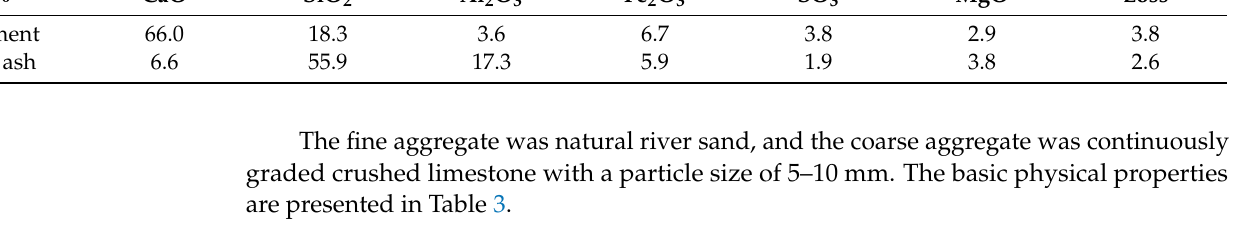
Table 3. Basic physical properties of coarse and fine aggregates.